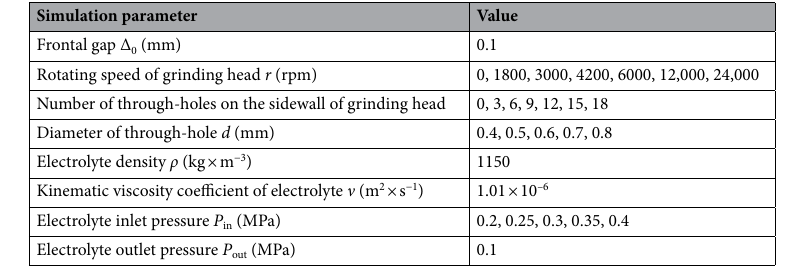
Table 1. Main parameters of flow field simulation of ECFG.